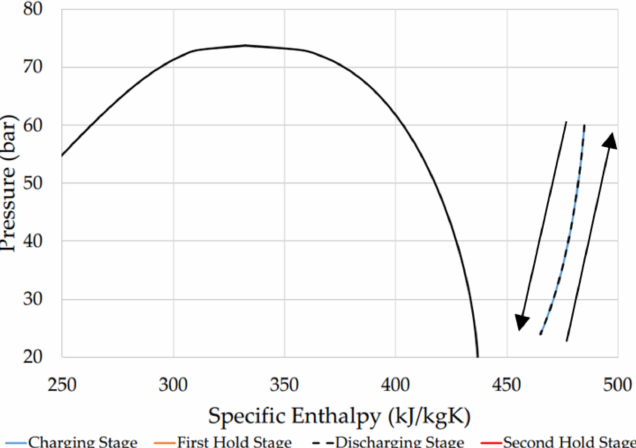
Figure 6. Pressure (bar) against specific enthalpy (kJ/kg · K) for an adiabatic CO 2 -based accumulator with the black lines representing the liquid–vapor dome for CO 2 and the arrows indicating direction of